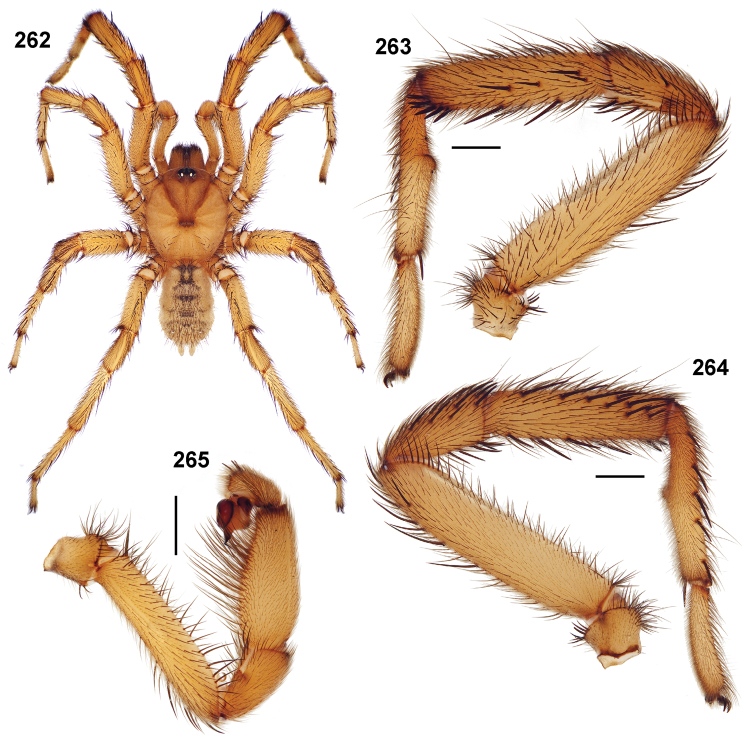
Aptostichus anzaborrego sp. n., male holotype from San Diego County (AP1199); scale bars = 1.0mm. 262 habitus [806106] 263 retrolateral aspect, leg I [806102] 264 prolateral aspect, leg I [806098] 265 retrolateral aspect, pedipalp [806104].